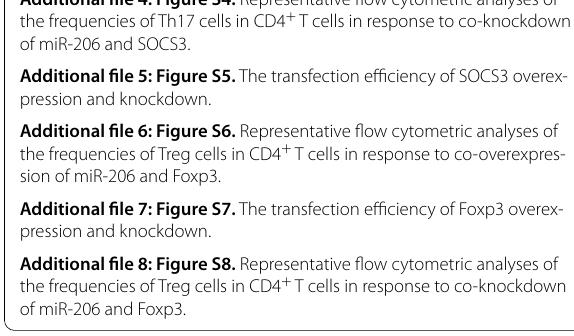
Additional file 4: Figure S4. Representative flow cytometric analyses of the frequencies of Th17 cells in CD4 + T cells in response to co-knockdown of miR-206 and SOCS3. Additional file 5: Figure S5. The transfection efficiency of SOCS3 overex- pression and knockdown. Additional file 6: Figure S6. Representative flow cytometric analyses of the frequencies of Treg cells in CD4 + T cells in response to co-overexpres- sion of miR-206 and Foxp3. Additional file 7: Figure S7. The transfection efficiency of Foxp3 overex- pression and knockdown. Additional file 8: Figure S8. Representative flow cytometric analyses of the frequencies of Treg cells in CD4 + T cells in response to co-knockdown of miR-206 and